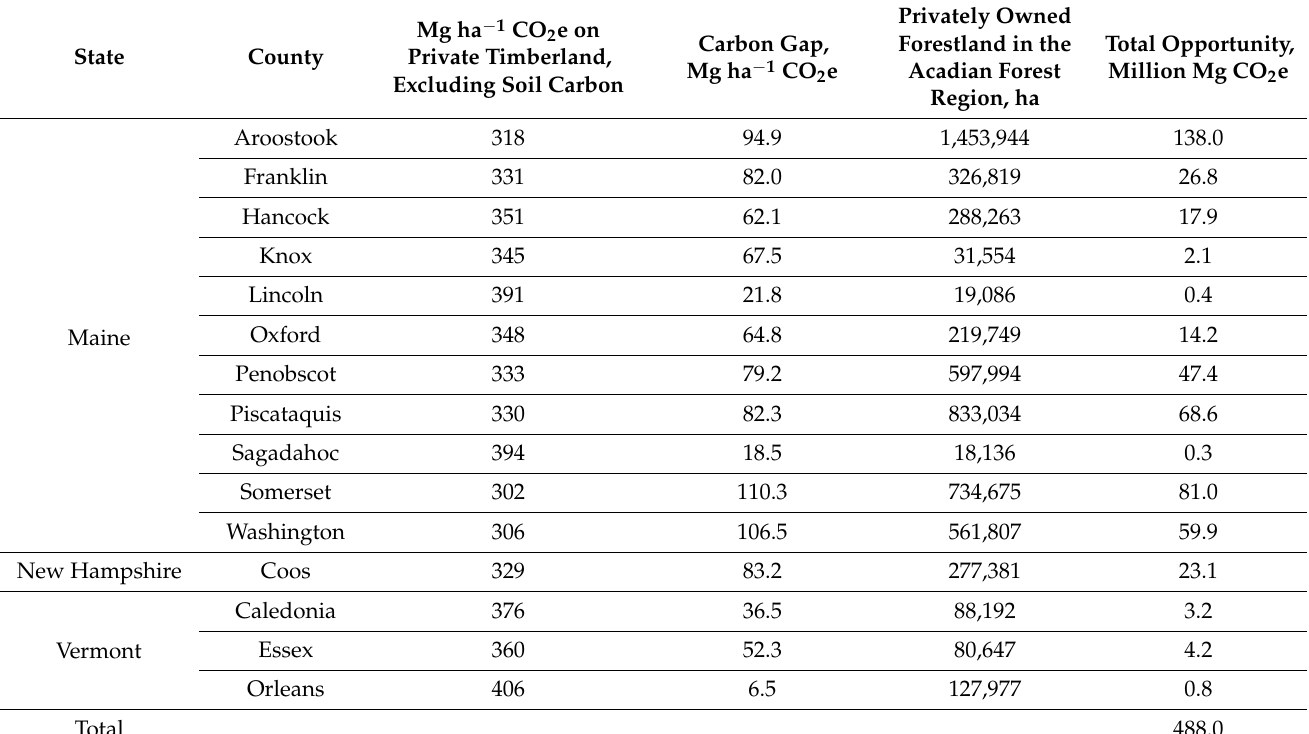
Table A1. Carbon storage opportunity per hectare and total carbon storage opportunity on privately owned timberland in the Acadian Forest of New England, by county. “Carbon gap” is the difference between average carbon storage per hectare of private timberland in the Acadian Forest and average carbon storage per hectare expected under EF in the Acadian Forest, based on the results of modeling in the Mountains of the Dawn